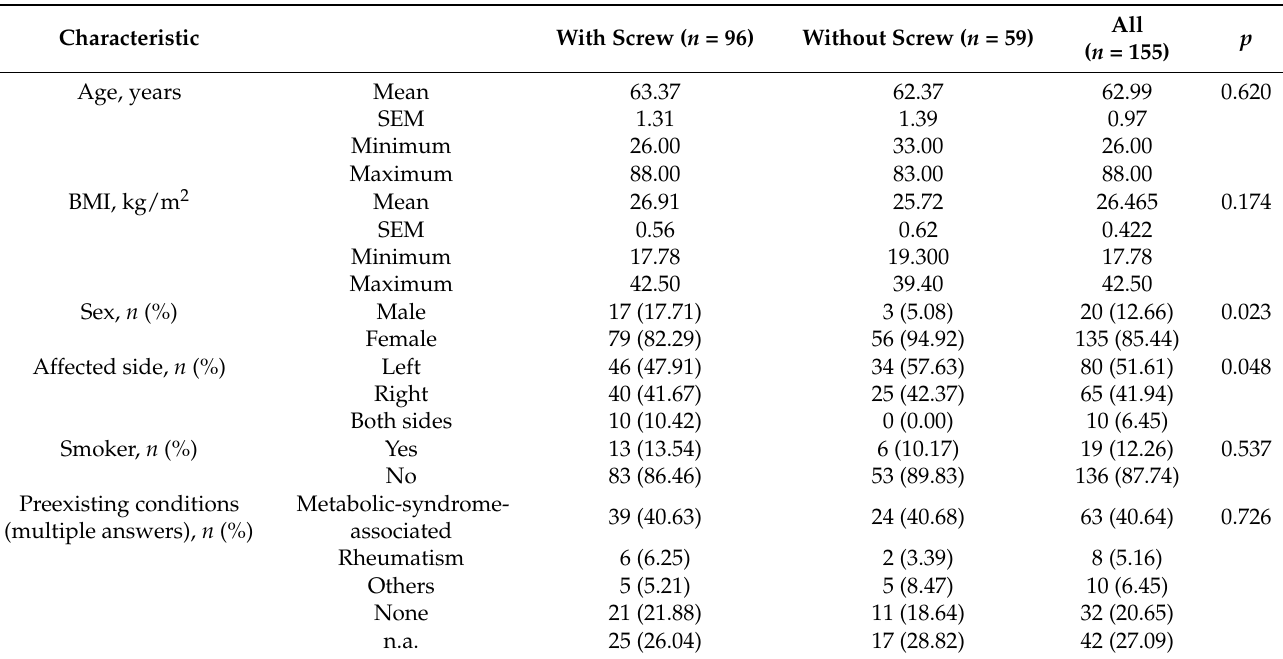
Table 1. Patient characteristics.